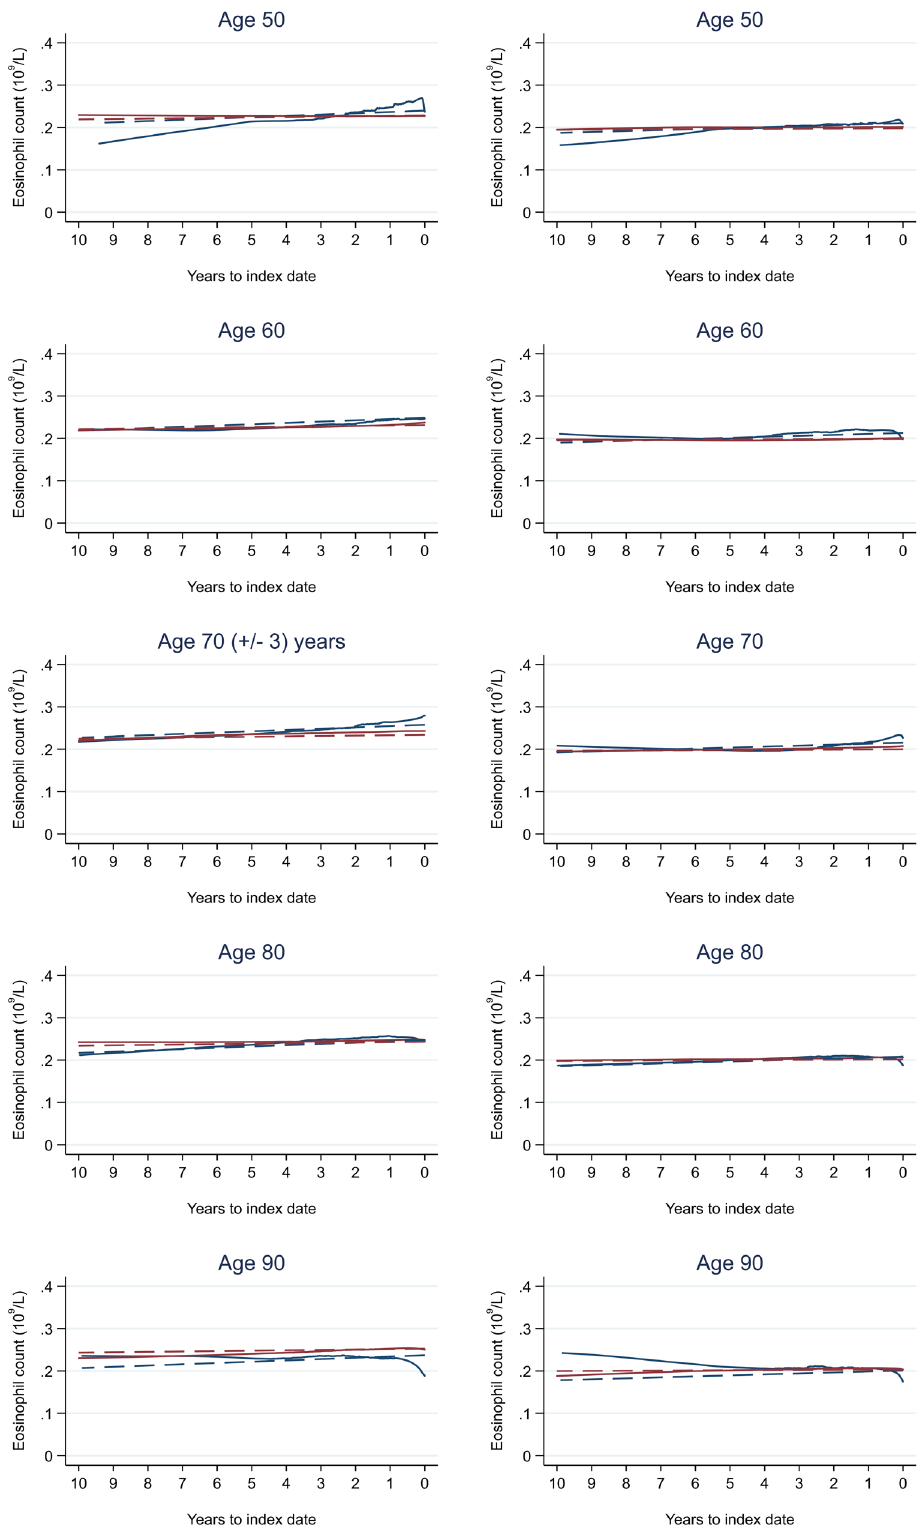
Figure 14. Eosinophil count trends between cases and controls, by age at index date 1,2 . 1 Index date was the date of diagnosis for cases and a randomly selected date in the patient’s study period for controls. 2 LOWESS trends are age (+/- 3 years) and modelled (fixed effects) trends are taken at that specific age. Legend: males (left) and females (right). Colorectal cancer (blue line) and no cancer (red line). LOWESS trend (solid line) and modelled trend (dashed line).